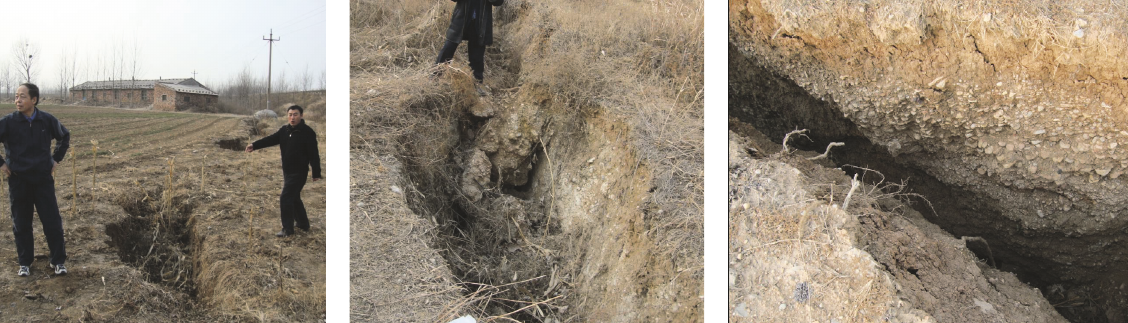
Figure 6: Field observation.